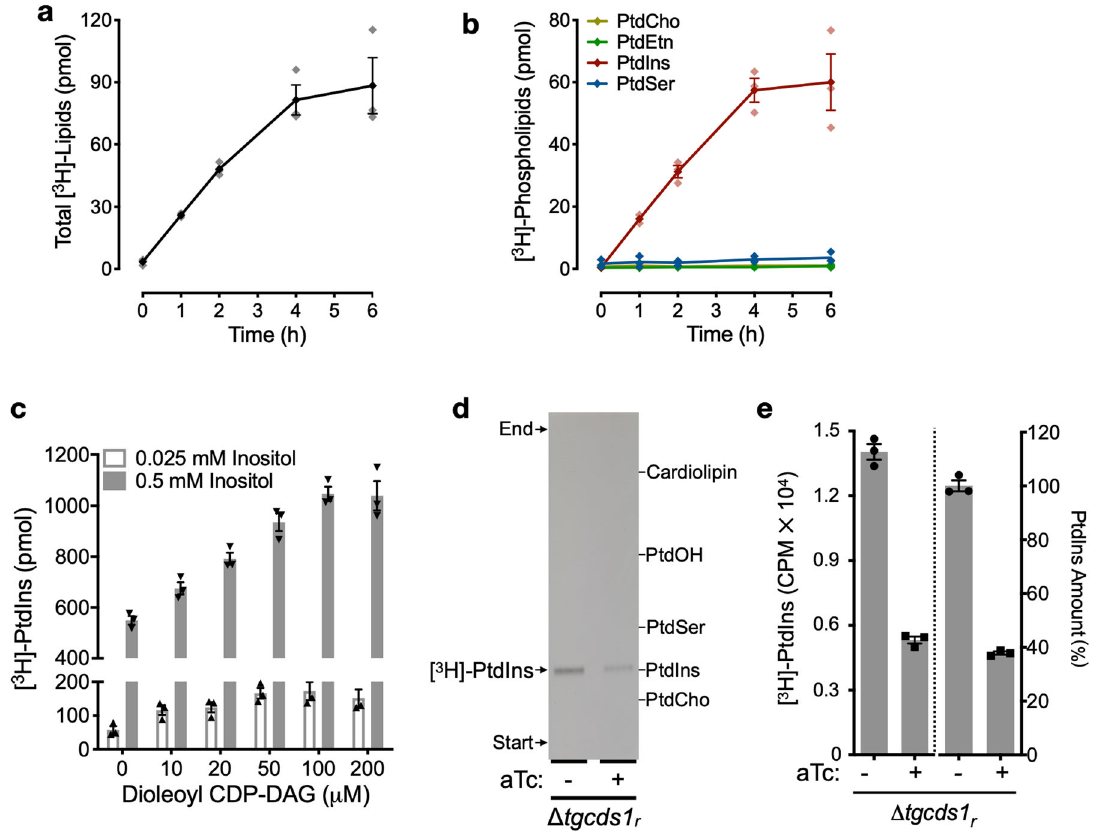
Fig. 1 Extracellular tachyzoites of Toxoplasma gondii can generate PtdIns by co-utilizing myo -inositol and CDP-diacylglycerol. a – c Radiolabeling of puri fi ed tachyzoites of the RH strain with myo -inositol. Parasites (10 8 /reaction) were incubated with [ 3 H]- myo -inositol (10 μ Ci) in the labeling medium for indicated periods, immediately followed by lipid extraction. Incorporation of radiotracer was quanti fi ed in total lipids ( a ) and in the major glycerophospholipid classes resolved by thin-layer chromatography ( b ). A conversion of CPM counts scored by liquid scintillation counter into absolute amounts was achieved using the formula (X CPM = Y pmol) derived from the reference counts in the substrate preparation (10 μ Ci, 0.025 mM). c shows the same assay as depicted in a , b except for that CDP-DAG and myo -inositol were included at speci fi ed concentrations (duration, 4 h). d Autoradiogram showing TLC-resolved lipids from radiolabeled parasites of the Δ tgcds1 r strain under on (-aTc) and off ( + aTc) conditions. The Δ tgcds1 r strain was precultured in aTc (1 μ M) for two passages (96 h) prior to radiolabeling assay. Fresh parasites (5 × 10 7 /reaction) were incubated with [ 3 H]- myo -inositol (10 μ Ci, 0.5 mM) for 4 h. Lipids were separated by TLC and visualized by X-ray detection ( – 80 °C, 40 h). e Quanti fi cation of PtdIns labeling and amount in the Δ tgcds1 r mutant. The left Y-axis shows the mean scintillation counts in TLC-scraped bands from d . The right Y -axis illustrates the steady-state amount of PtdIns in the mutant precultured in the absence or presence of aTc. The data in a – c and e represent the mean with S.E. from 3 independent